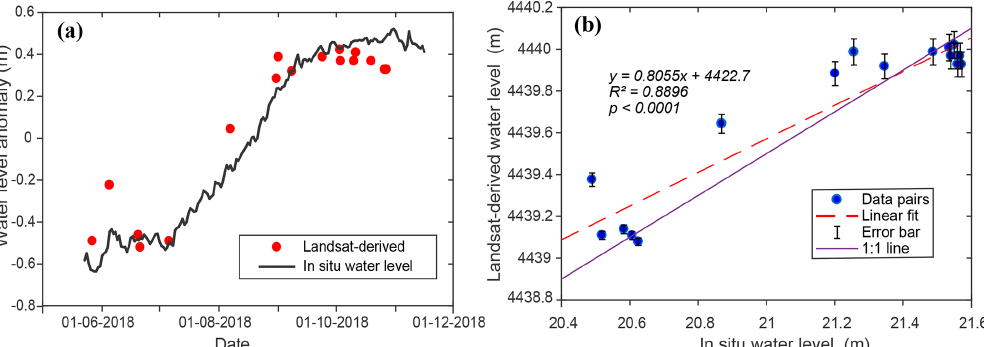
Figure 8. (a) In situ water level anomaly versus Landsat-derived water level anomaly in Yamzhog Yumco; (b) linear regression between the Landsat-derived water levels and in situ water levels during the same period.